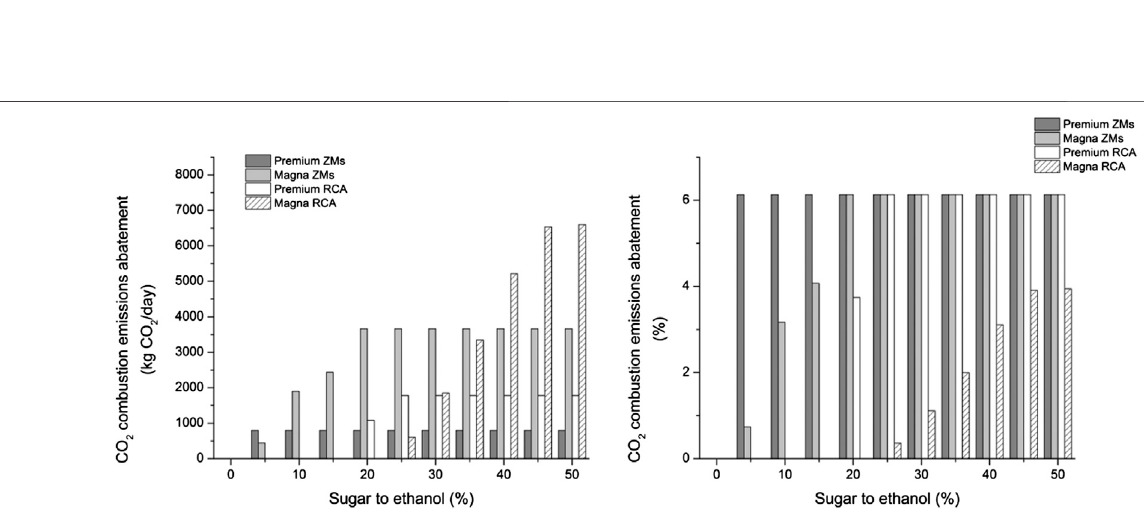
Frontiers in Energy Research |